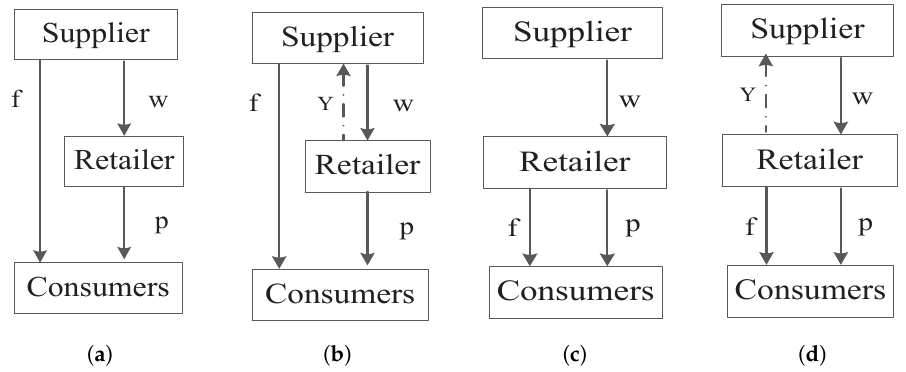
Figure 1. Four possible cases in the decentralized mode. ( a ) Case SN; ( b ) Case SS; ( c ) Case RN; and ( d ) Case